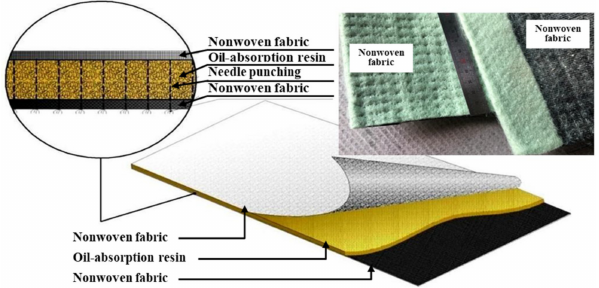
Figure 2. Composition of the smart liner.